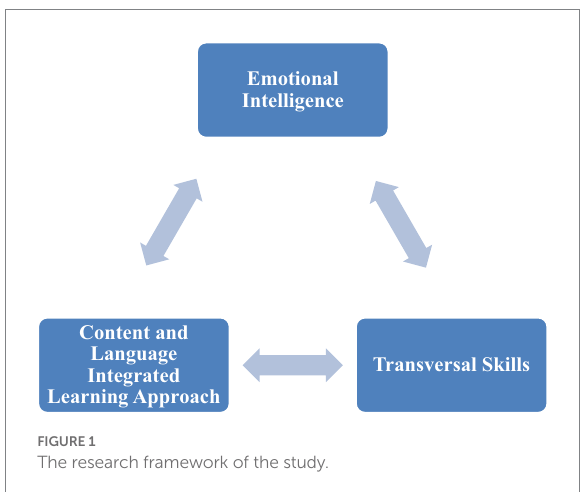
FIGURE 1 The research framework of the